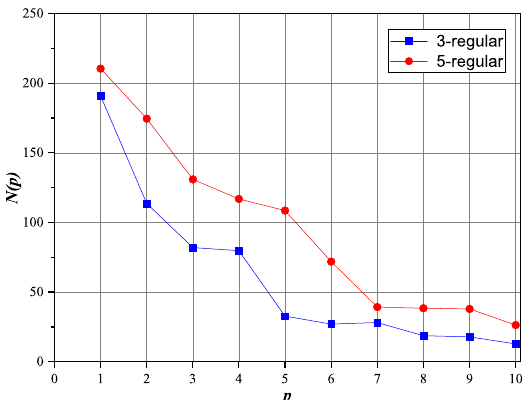
Figure 8. N ( p ) is the mean of the minimum number of measurements required to obtain one best solution for all instances at the circuit depth p . N ( p ) tends to decrease as p